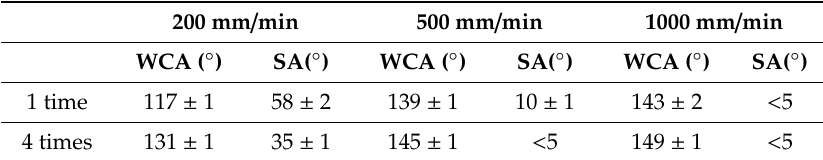
Table 2. Values of the WCA and SA obtained for the coatings aged for 5 days and dipped for 5 min times; samples used different dipping rates.